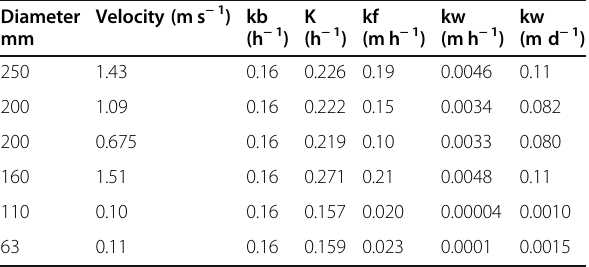
Table 4 Results obtained from K and kw for pipelines of different diameter and flow velocity Diameter